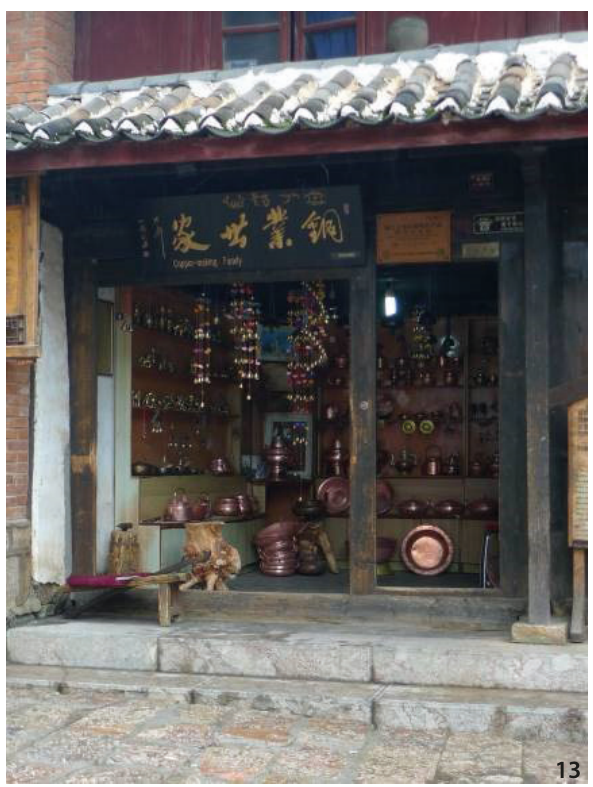
Figure 13 ’Cooper Family’ is one of the traditional handcraft shops supported by Business Permit programme (Source: the